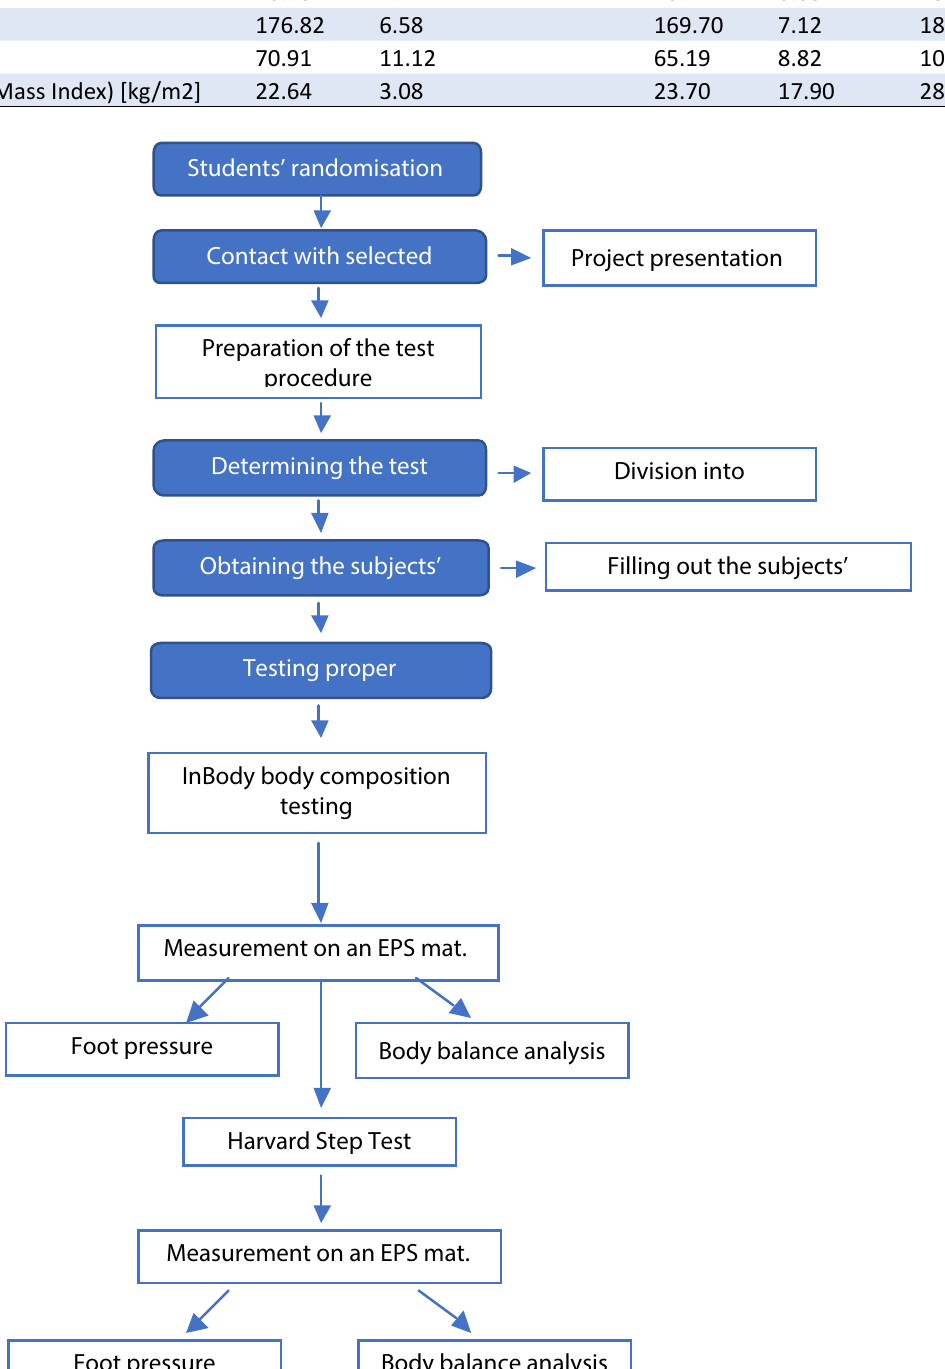
Measurement on an EPS mat.